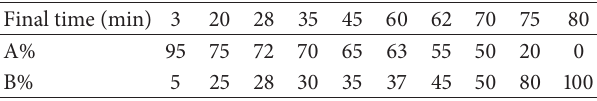
Table 2: Solvent gradient conditions with linear gradient ∗ . Table 3: Microwave digestion